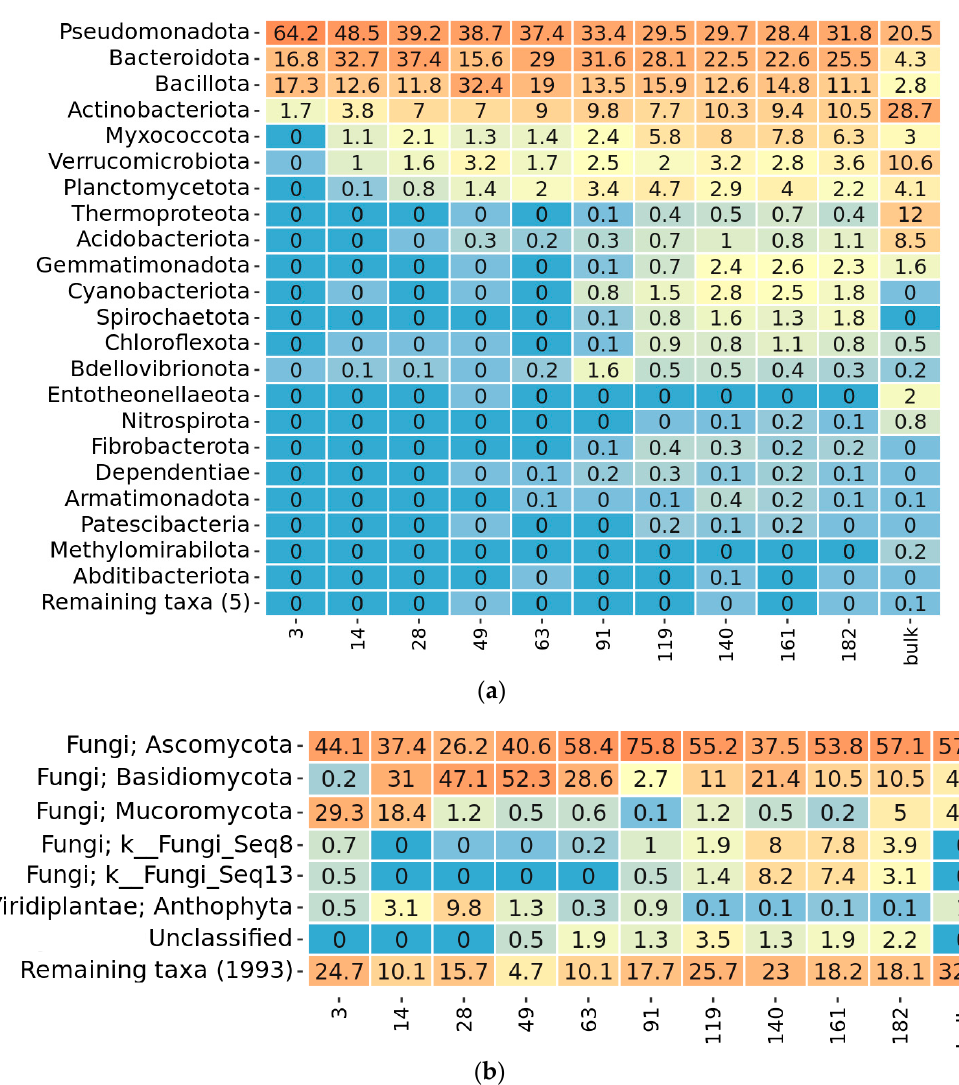
Figure 4. Heatmap of the most abundant phyla in the microbial straw decomposing community from ten sampling points, based on ( a ) prokaryotic and ( b ) eukaryotic amplicon sequencing data. The relative abundance is given in % of the read count of each sampling day, with orange for maximal and blue for minimal values. The name of each sample indicates the day from the beginning of the experiment when the sample was taken. Bulk stands for the control sample of chernozem soil.